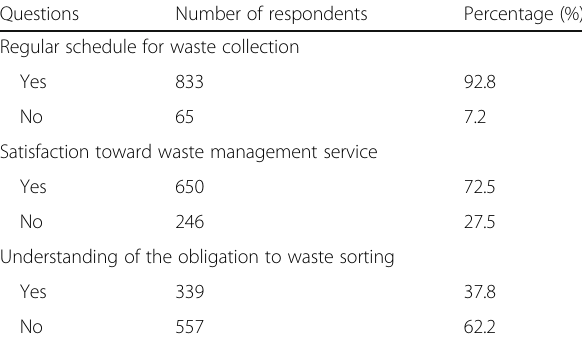
Table 4 Understanding of the obligation to waste sorting